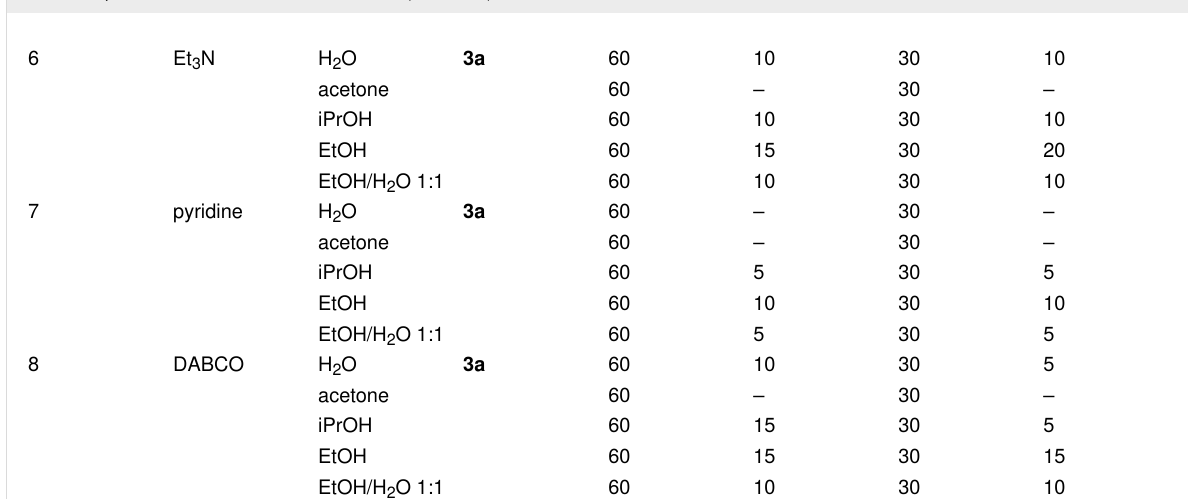
Table 2: Optimization of the reaction conditions. a (continued)